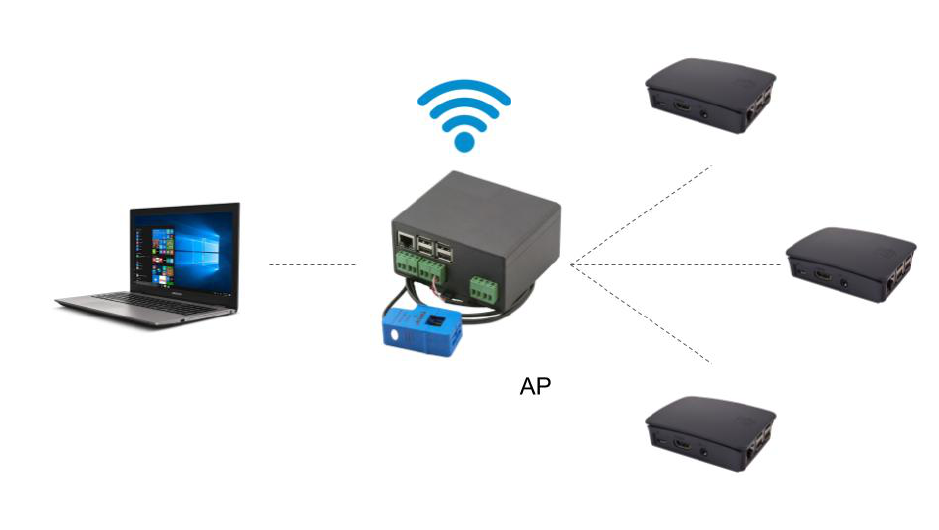
Figure 1. Outline of the network, including the laptop used to access the systems